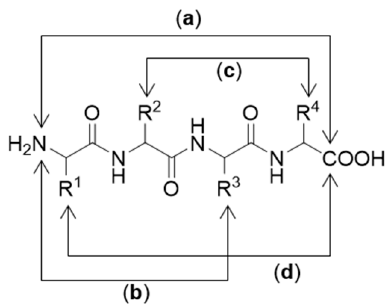
Figure 22. Different cyclization arrangements: ( a ) head-to-tail chain; ( b ) head-to-side chain; ( c ) side chain-to-side chain; ( d ) tail-to-side chain.